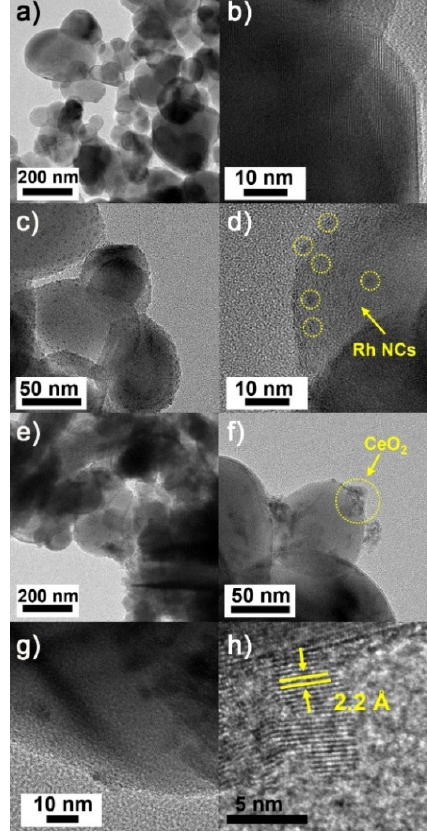
Figure 3. TEM images of ( a , b ) TiO 2 , ( c , d ) Rh–TiO 2 hybrid, and ( e – g ) Rh–TiO 2 –CeO 2 hybrid photocatalysts. ( h ) A high-resolution TEM image focused on Rh NC in Rh–TiO 2 –CeO 2 hybrid photocatalysts.